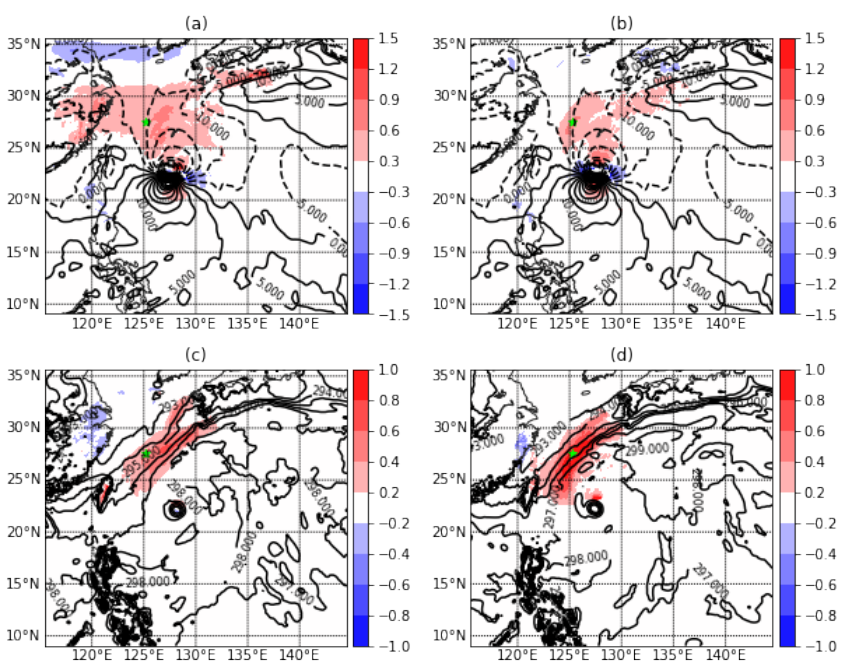
Figure 11. The wind pressure field and increments of signal observations for zonal wind ( a ) and temperature ( c ) near the surface at 18:00 UTC on 26 September 2015 (left column). The right column show the same at 00:00 UTC on 27 September.